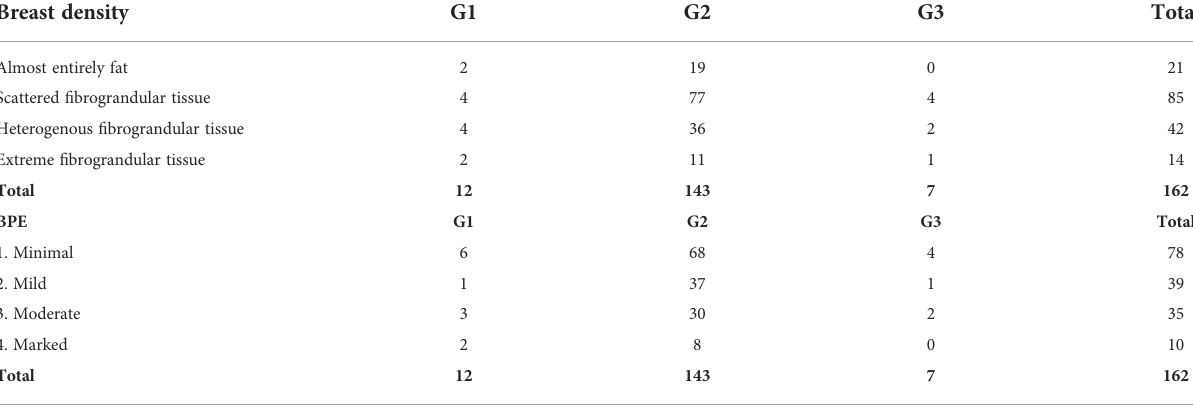
TABLE 2 Comparison between feature G vs . MRI and feature G vs . BPE. Breast density G1 G2 G3 Total